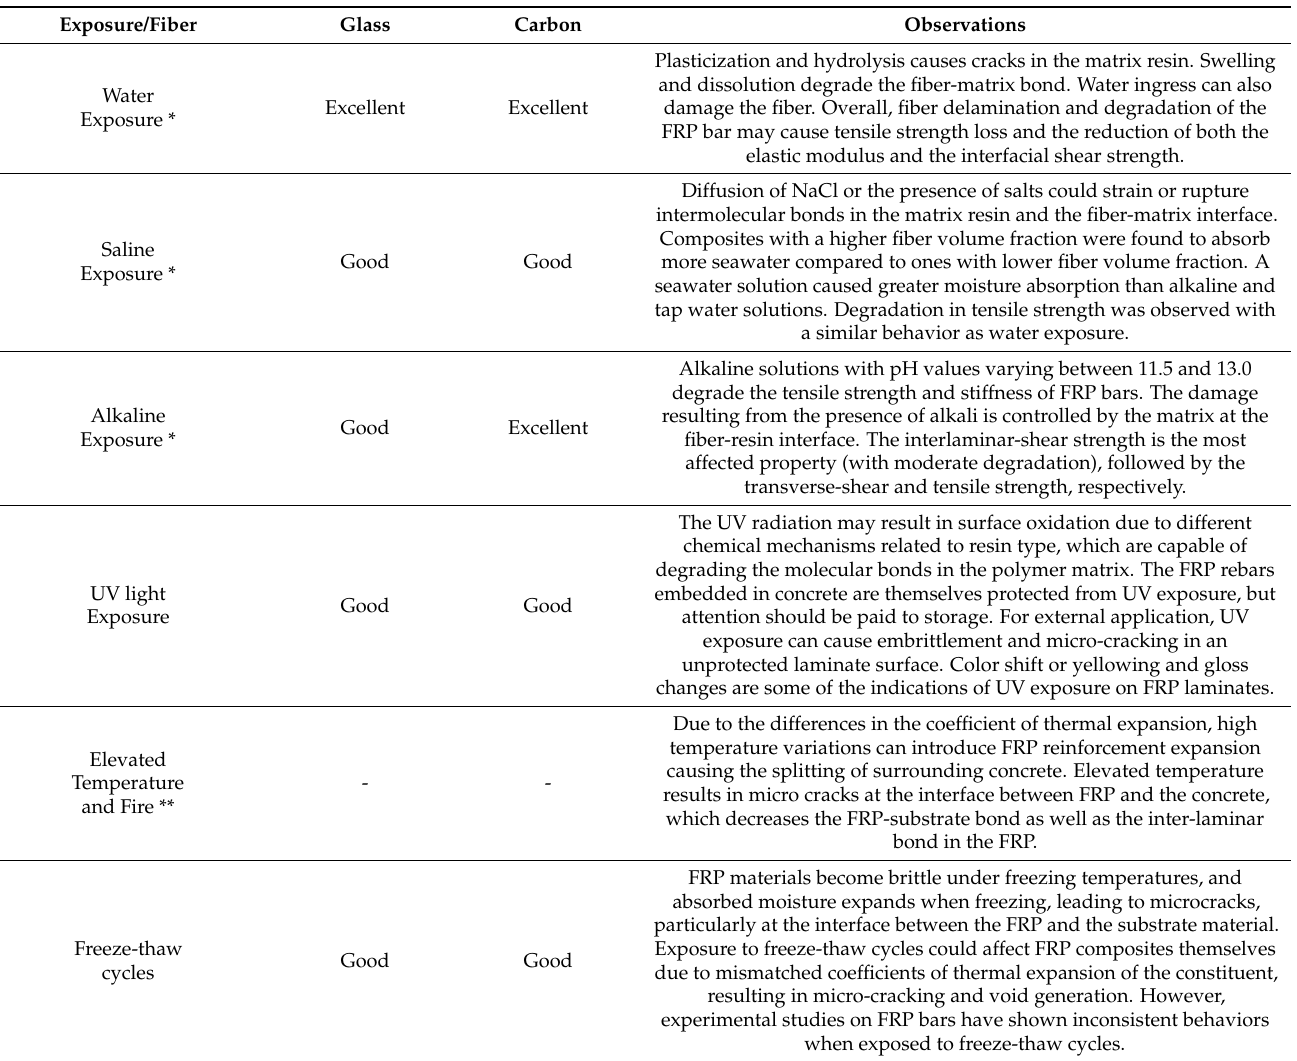
Table 9. Performance summary of FRP composites under harsh environmental conditions